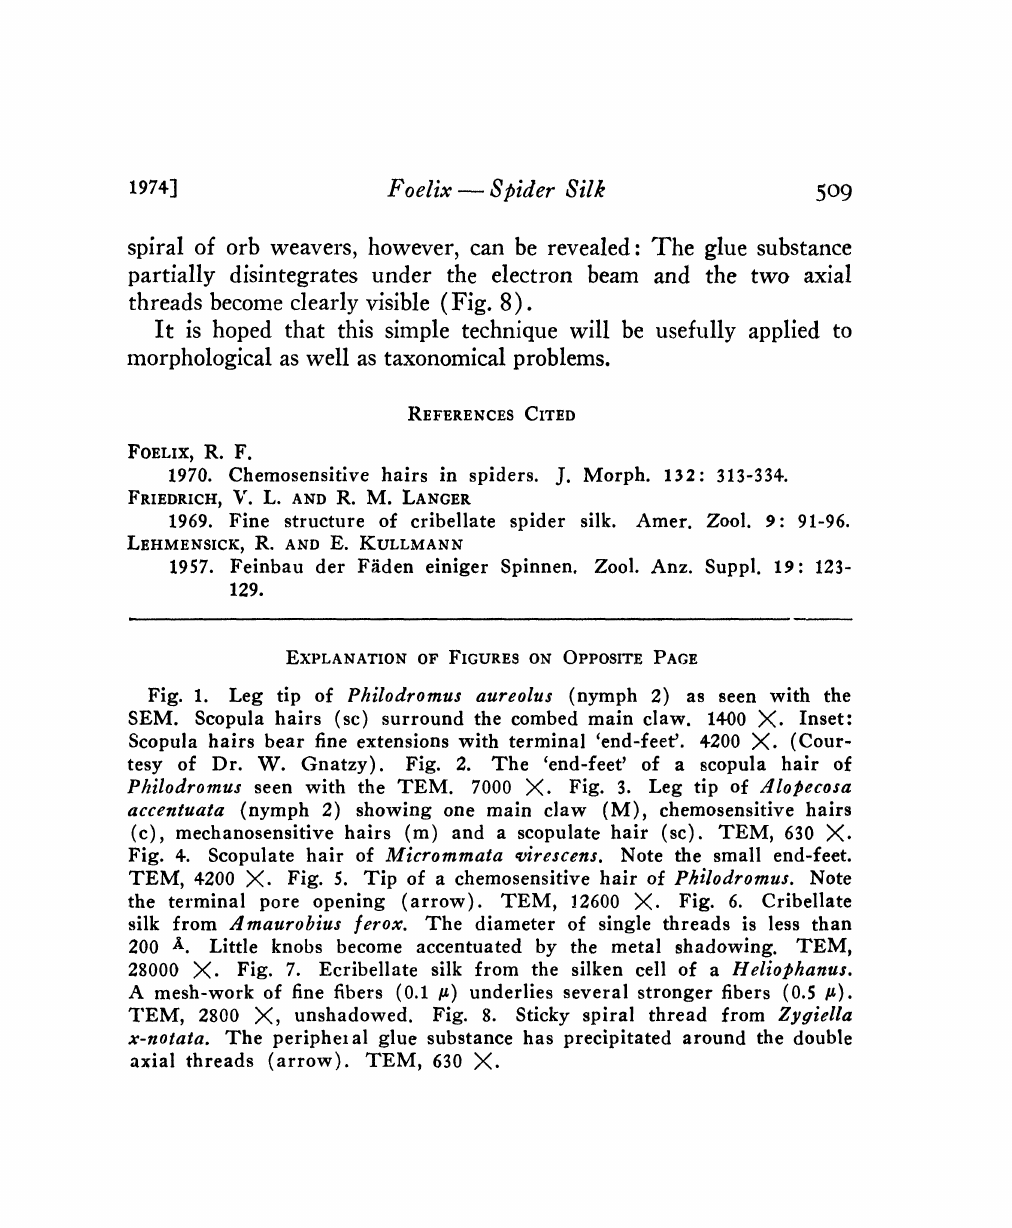
Fig. 1. Leg tip of Philodromus aureolus (nymph 2) as seen with the SEM. Scopula hairs (sc) surround the combed main claw. 1400 X. Inset: Scopula hairs bear fine extensions with terminal ’end-feet’. 4200 )<. (Cour- tesy of Dr. W. Gnatzy). Fig. 2. The ’end-feet’ of a scopula hair of Philodromus seen with the TEM. 7000 X. Fig. 3. Leg tip of Aloecosa accentuata (nymph 2) showing one main claw (M), ehemosensitive hairs (e), meehanosensitive hairs (m) and a seopulate hair (se). TEM, 630 X. Fig. 4. Seopulate hair of Micrommata ,irescens. Note the small end-feet. TEM, 4200 X. Fig. 5. Tip of a ehemosensitive hair of Philodromus. Note the terminal pore opening (arrow). TEM, 12600 X. Fig. 6. Cribellate silk from A maurobius [erox. The diameter of single threads is less than 200 A. Little knobs become accentuated by the metal shadowing. TEM, 28000 X. Fig. 7. Eeribellate silk from the silken cell of a Helio#hanus. A mesh-work of fine fibers (0.1 #) underlies several stronger fibers (0.5 #). TEM, 2800 X, unshadowed. Fig. 8. Sticky spiral thread from Zygiella x-notata. The peripheral glue substance has precipitated around the double axial threads (arrow). TEM, 630